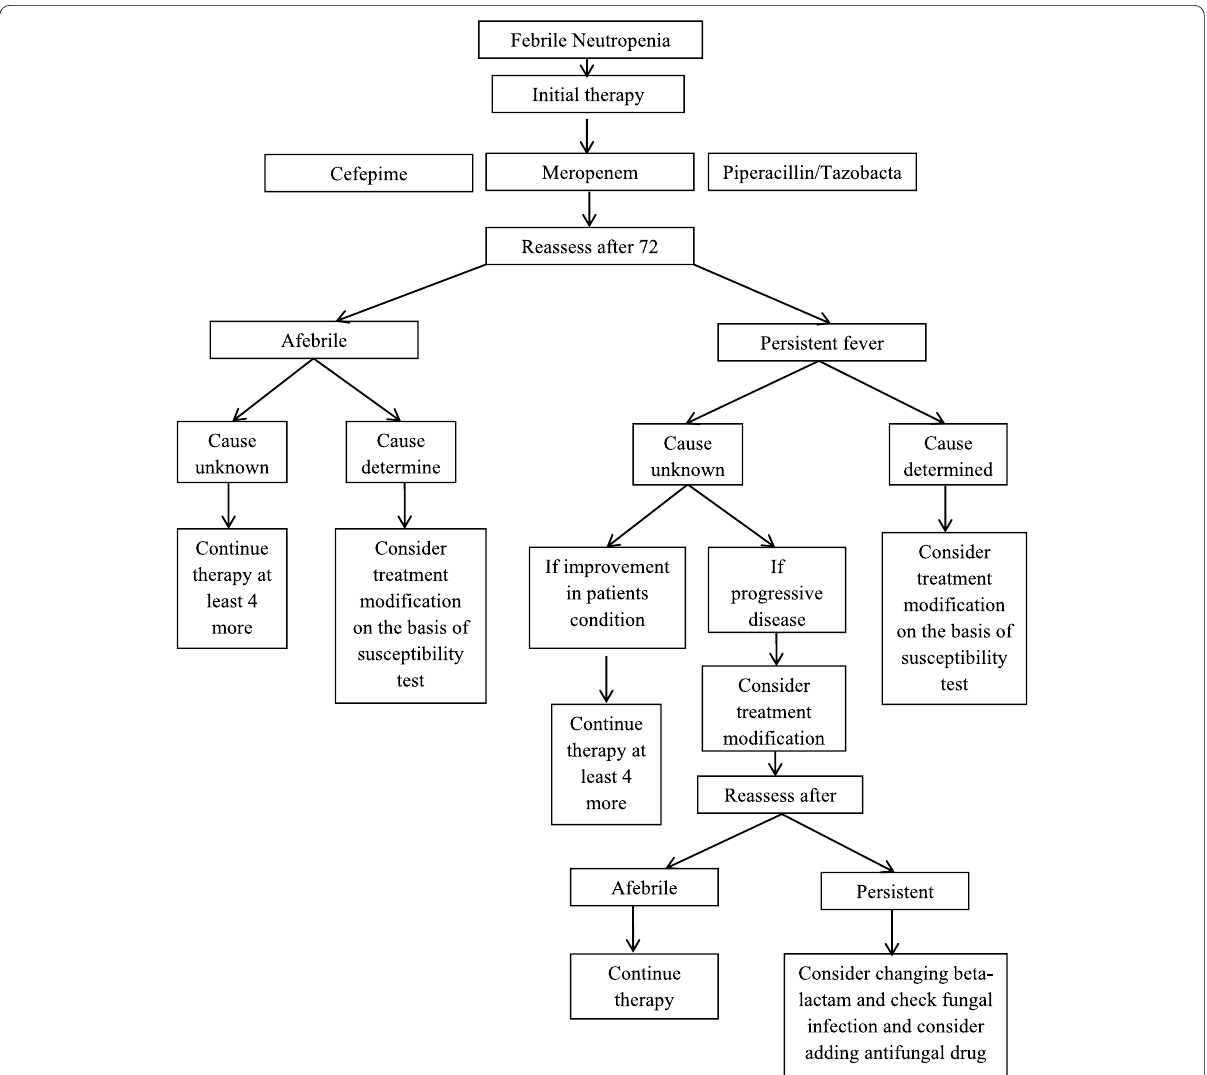
Fig. 1 Flow chart of therapeutic intervention in this